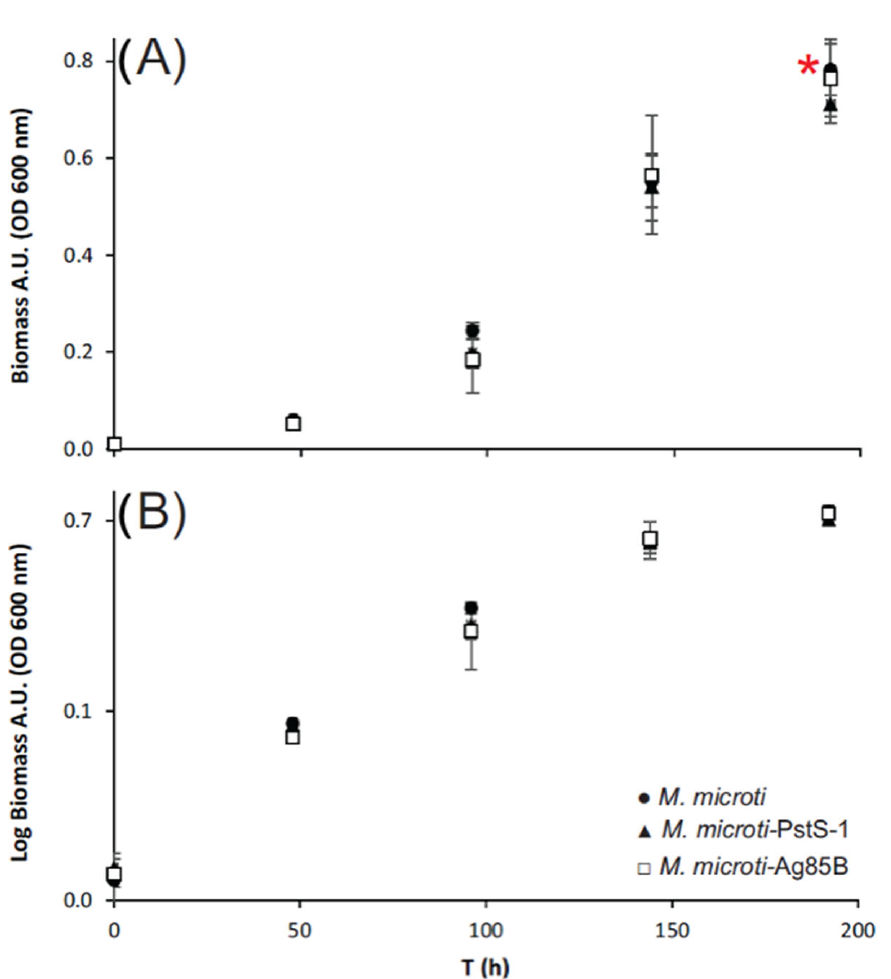
Figure 2. Kinetic growth of M. microti strains in Sauton media. The biomass accumulation in absorbance units (A.U.) measured by optical density (O.D.) during 196 h: ( A ) Lineal scale growth and ( B ) Log scale growth of the strains M. microti (closed circles), M. microti -PstS-1 (closed triangles) and M. microti -Ag85B (open squares). The red asterisk indicates the collection time for protein analysis.